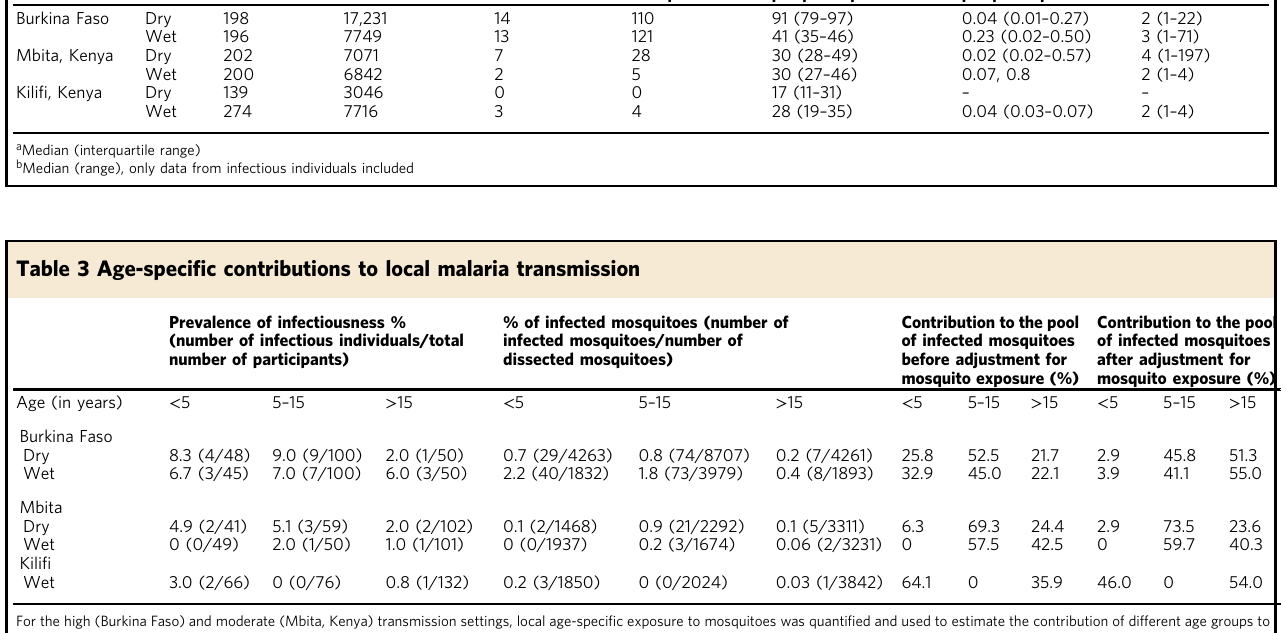
Table 2 Membrane feeding assays Study site